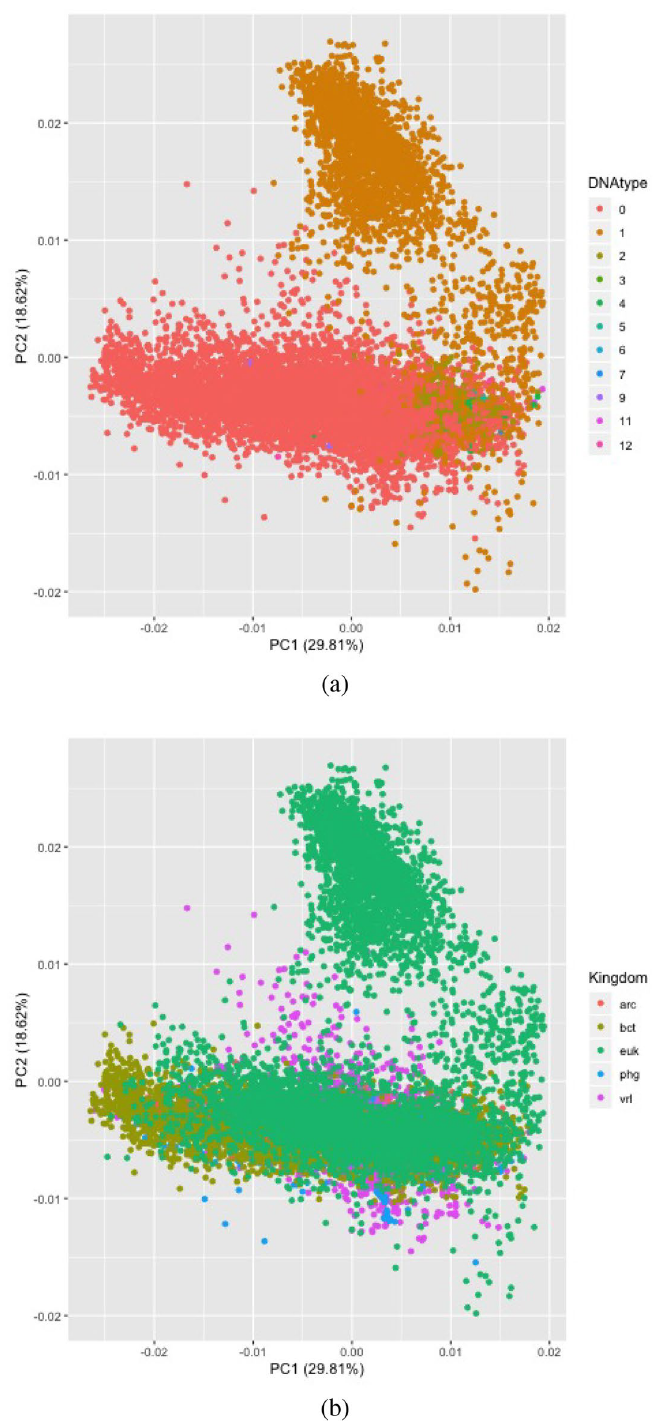
Figure 3. PCA for Kingdoms and DNA-Type. ( a ) Represents DNA-type and ( b ) represents Kingdom. The vertical labels correspond with the color code for the data points among the plots. The original DNA-type distinction from Genbank is used: 0 (nuclear), 1 (mitochondrion), 2 (chloroplast), 3 (cyanelle), 4 (plastid), 5 (nucleomorph), 6 (secondary endosymbiont), 7 (chromoplast), 8 (leucoplast), 9 (NA), 10 (proplastid), 11 (apicoplast), 12 (kinetoplast), and our kingdom discrimination is used: arc (archaeal), bct (bacterial), euk (eukaryotic), phg (phageal), vrl (viral). The horizontal axis of the PCA plots showcases the distribution of data along the first principal component while the vertical showcases along the second principal